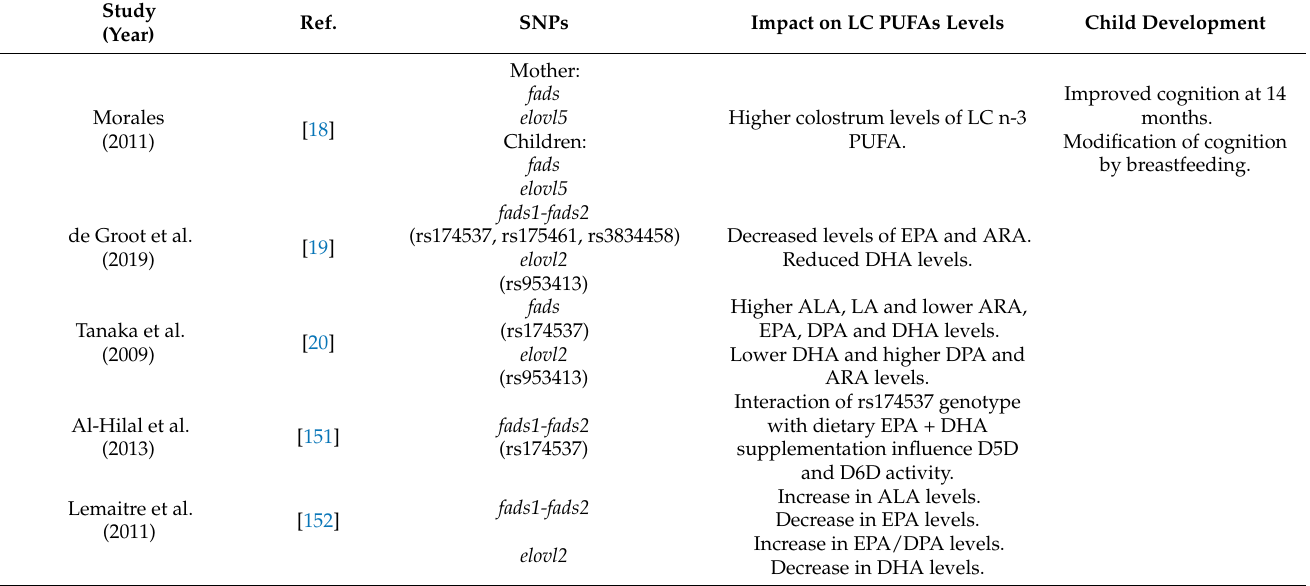
Table 1. Major SNPs involved in variations of LC PUFAs levels. fads: fatty acid desaturase; elovl: elongase; LC n-3 PUFA: n-3 long chain polyunsaturated fatty acid; EPA: eicosapentaenoic acid; ARA: arachidonic acid; DHA: docosahexaenoic acid; ALA: α -linolenic acid; LA: linoleic acid; DPA: docosapentaenoic acid; D5D: delta-5 desaturase; D6D: delta-6